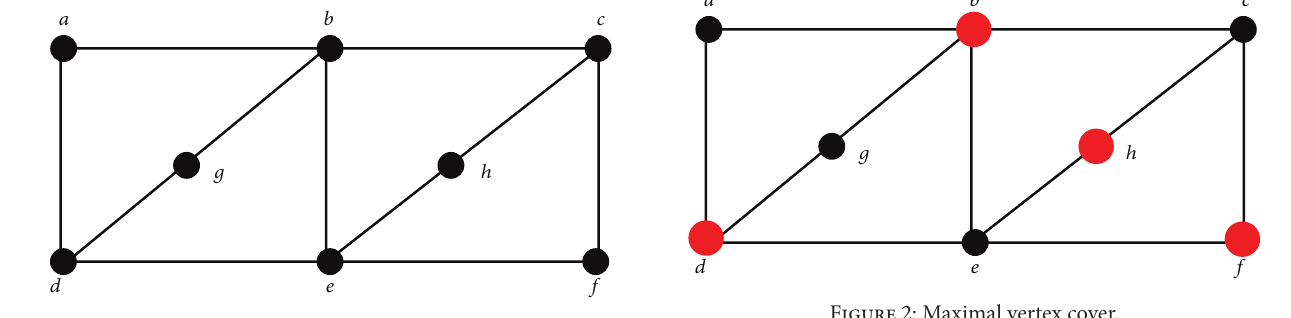
Figure 2: Maximal vertex